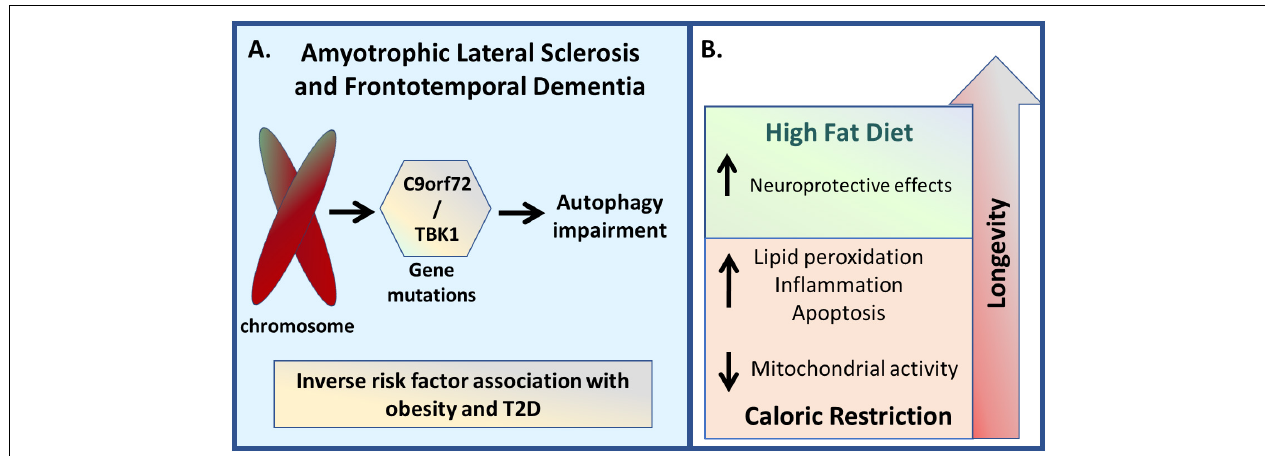
FIGURE 6 | Amyotrophic lateral sclerosis and Frontotemporal Dementia. (A) Genetic variations in genes such as C9orf72 and TBK1 are linked with both ALS and FTD disease development, which are associated with autophagy impairment. Besides that, since it is also associated with hypermetabolic and dyslipemia states, both conditions seem to present an inverse risk factor association with obesity and T2D. (B) Regarding the non-pharmacological inhibition, caloric restriction demonstrated to decrease lifespan due to an increase in lipid peroxidation, inflammation, and apoptosis, as well due to a reduction in mitochondrial activity, while high-energy diets resulted in increased